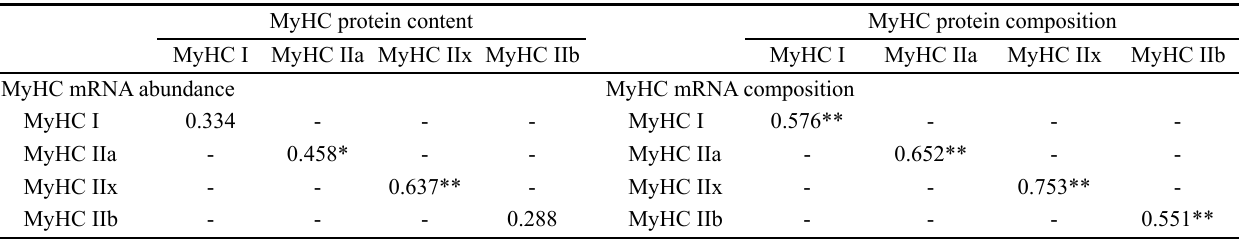
Table 3. Correlations of MyHC mRNA transcription with its protein expression in porcine LM during postnatal growth